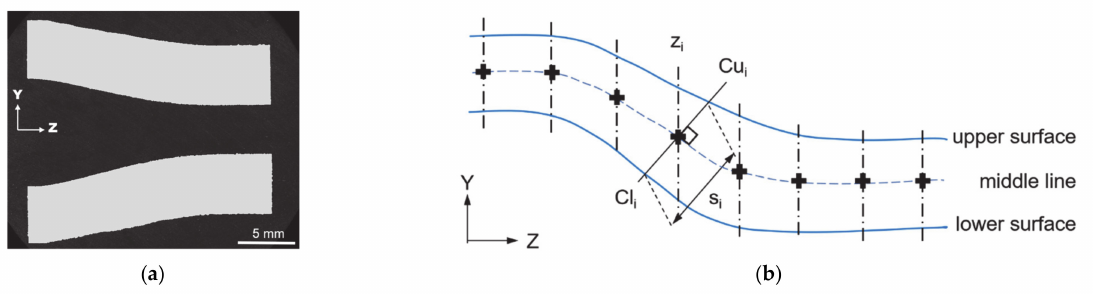
Figure 7. ( a ) Longitude section sample and ( b ) method to calculate the wall thickness between two